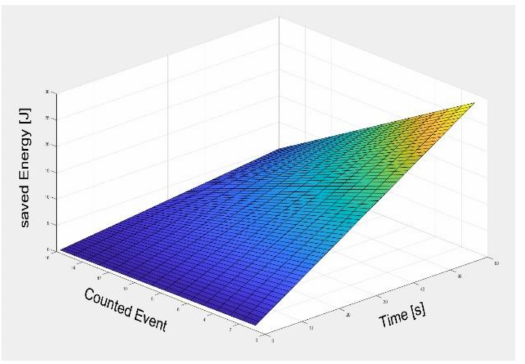
Figure 14. Reduced energy consumption with the parameters time and number of events.